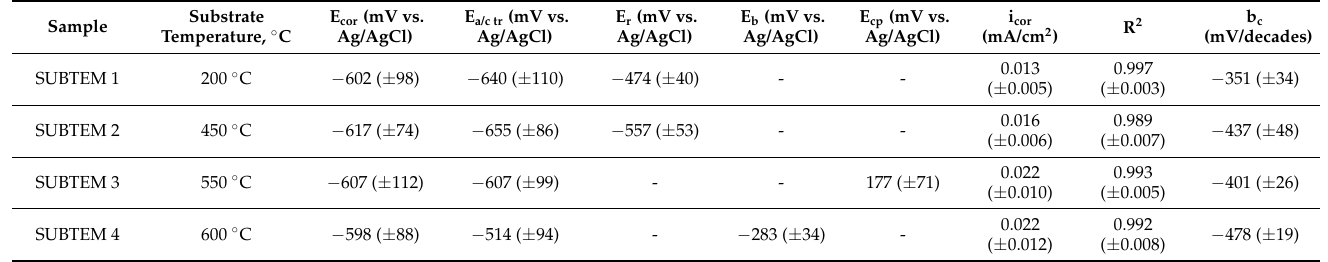
Table 5. Electrochemical values of the coatings immersed in 3.5% NaCl at 25 ◦ C: Effect of substrate temperature.